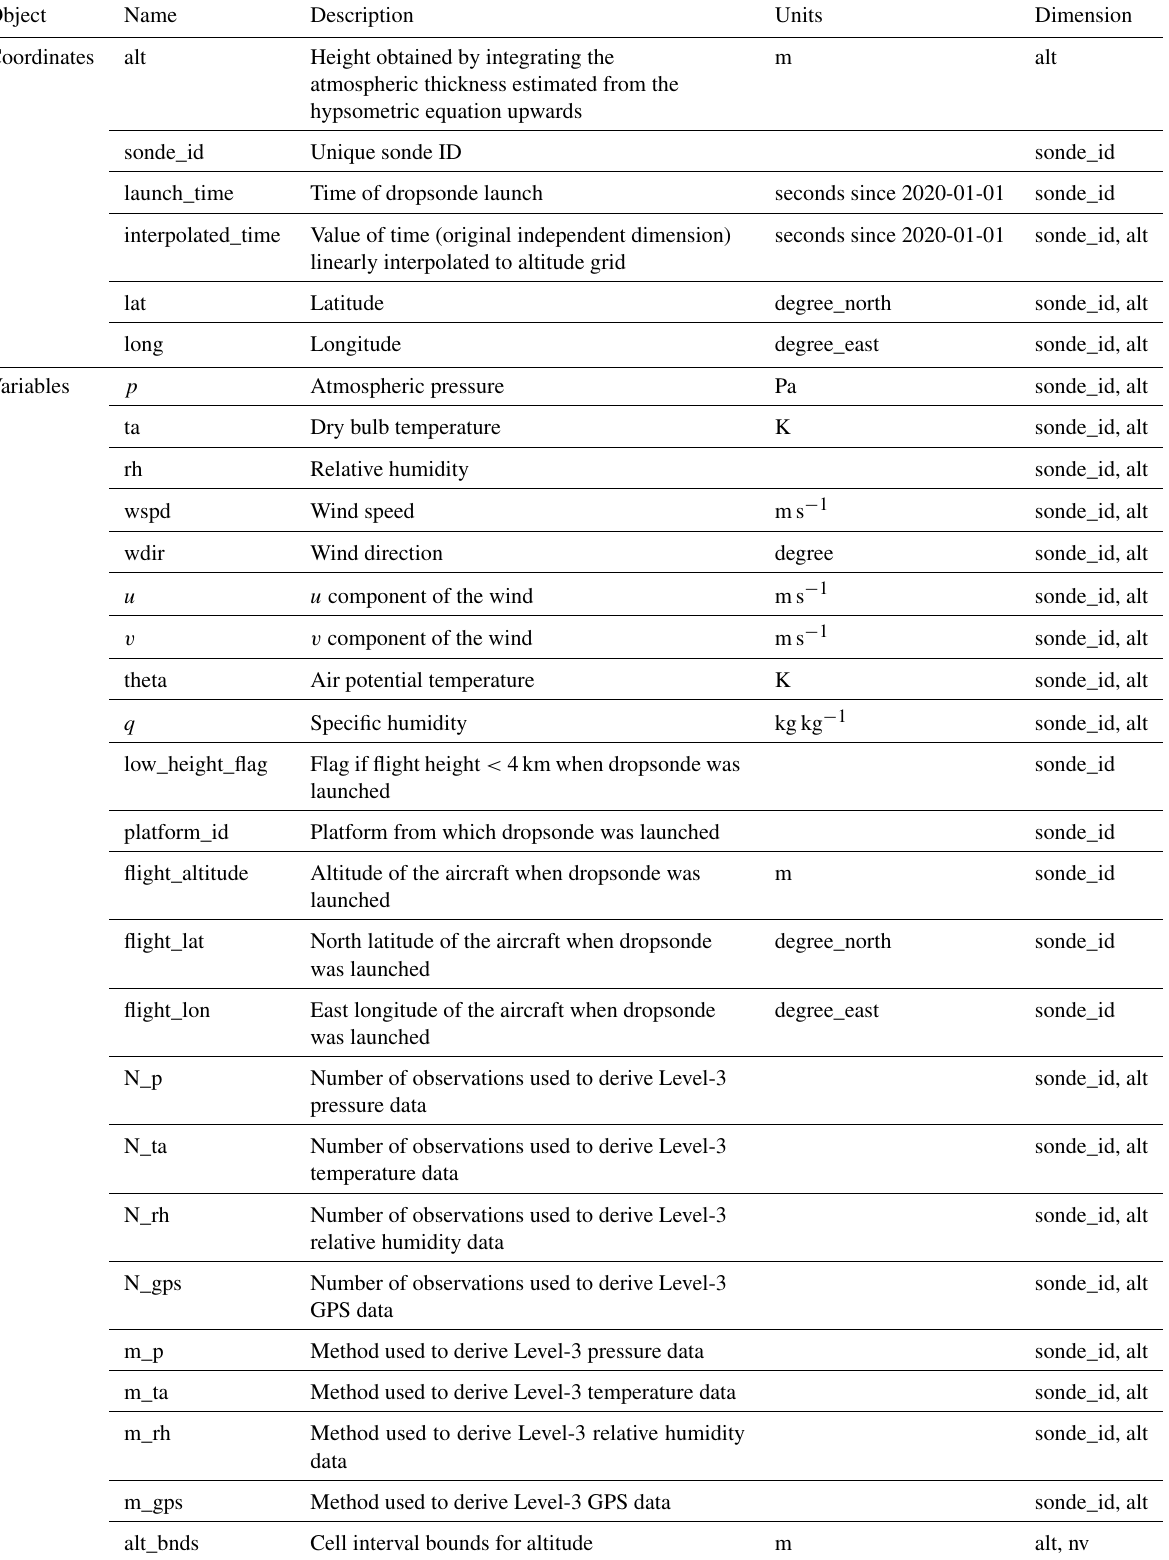
Table 8. The structure for the Level-3 product, outlining the coordinates and variables and their corresponding descriptions, units and